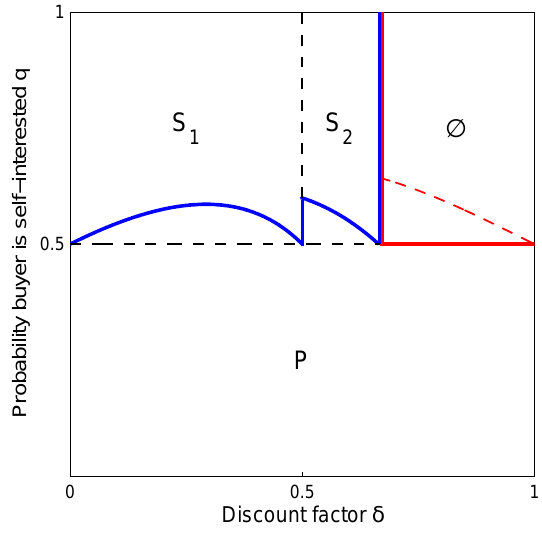
Figure 1. Perfect Bayesian equilibrium for q ∈ (0 , 1)